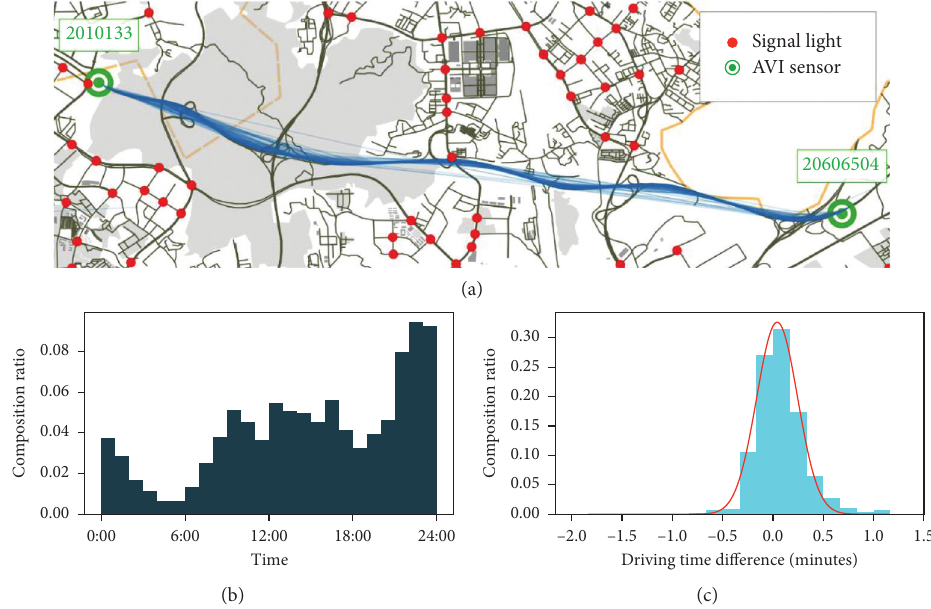
Figure 6: (a) Trajectories of samples. (b) Temporal distribution of the samples. (c) Histogram of the temporal constraint between 6:00 and 7: 00 (fitting result: μ � 0 . 25 and σ � 1 . 22, goodness of fit: